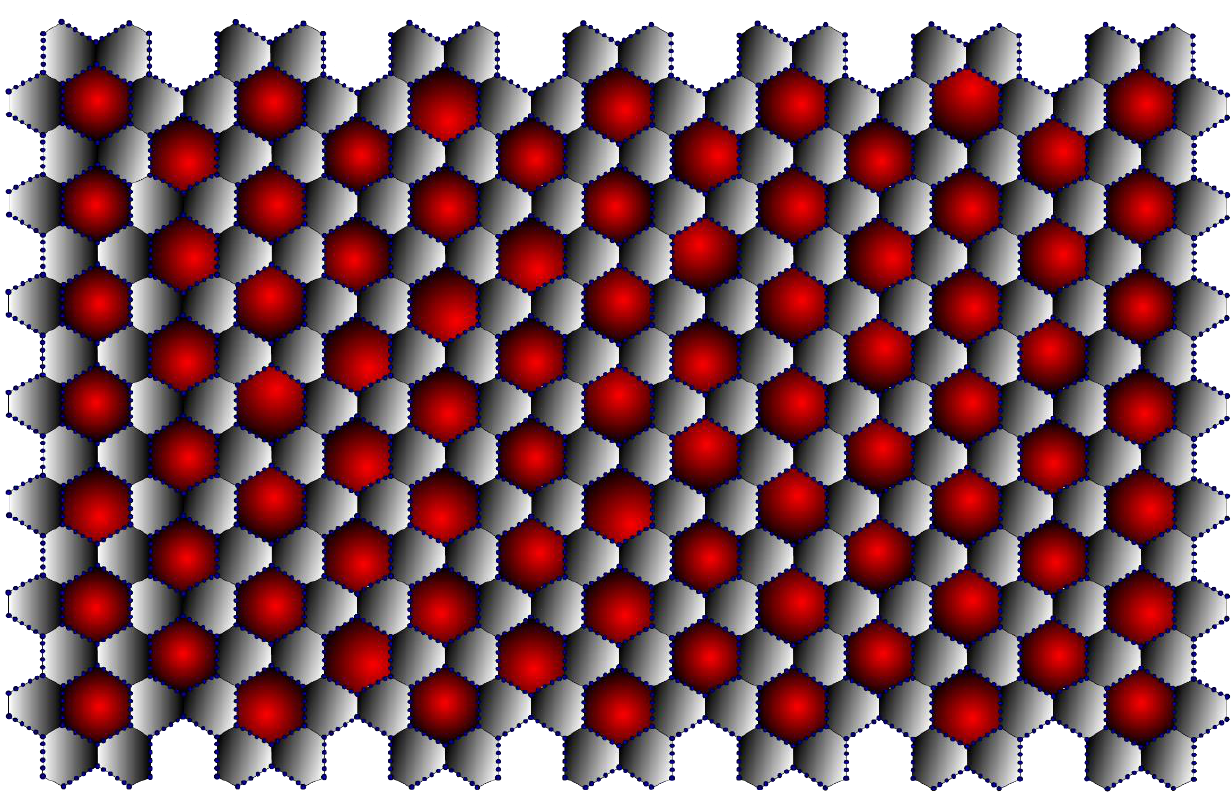
Figure 13. β -Graphdiyne Figure 13. 𝛽 - Graphdiyne (7,7) Table 12. Partition Table for 𝛽 - Graphdiyne Edge types Frequency